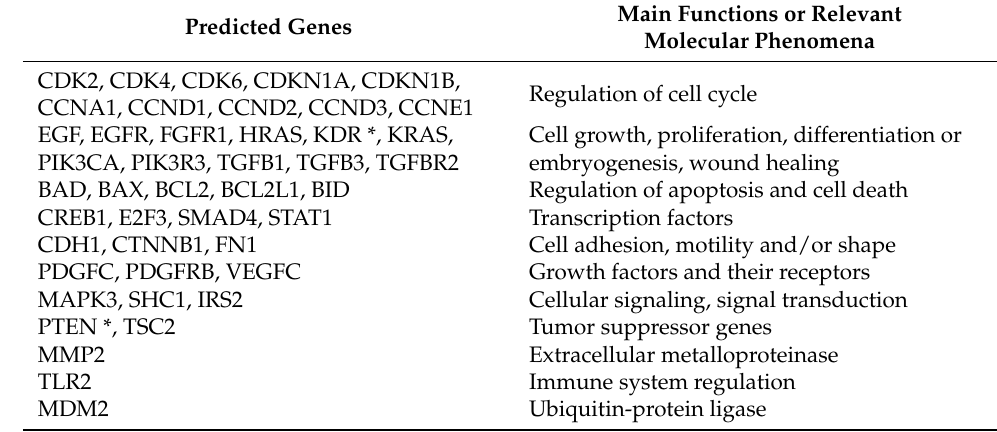
Table 2. Top 44 of the predicted genes/proteins of significance to CRC. Predicted Genes